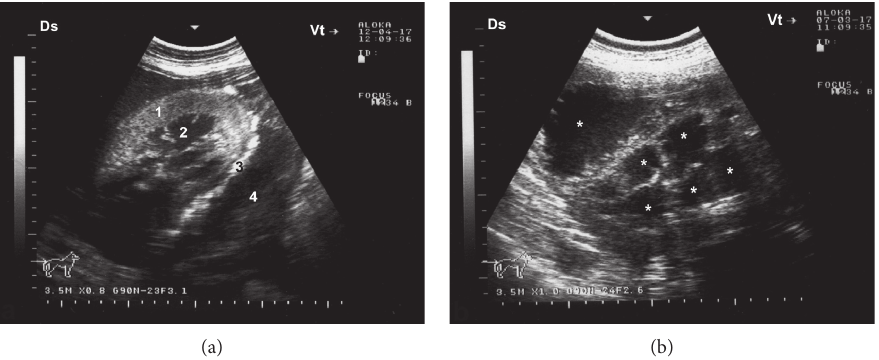
Figure 13: Transabdominal ultrasonographic examination of pyelonephritis in camels. Image (a) shows transcutaneous scanning of the right kidney with pyelonephritis in a male camel caused by E. coli . The renal capsule was imaged hyperechogenic with fibrin tags and the renal cortex appeared echogenic. A hypoechoic fluid was imaged surrounding the kidney. Image (b) shows transrectal view of unilateral pyelonephritis in a 6-year-old female camel caused by Staphylococcus lugdunensis . Heterogeneous contents were identified with multi- chambers containing echogenic fluid (stars). The cortex could not be differentiated from the medulla. 1, cortex; 2, medulla; 3, renal capsule; 4, perirenal